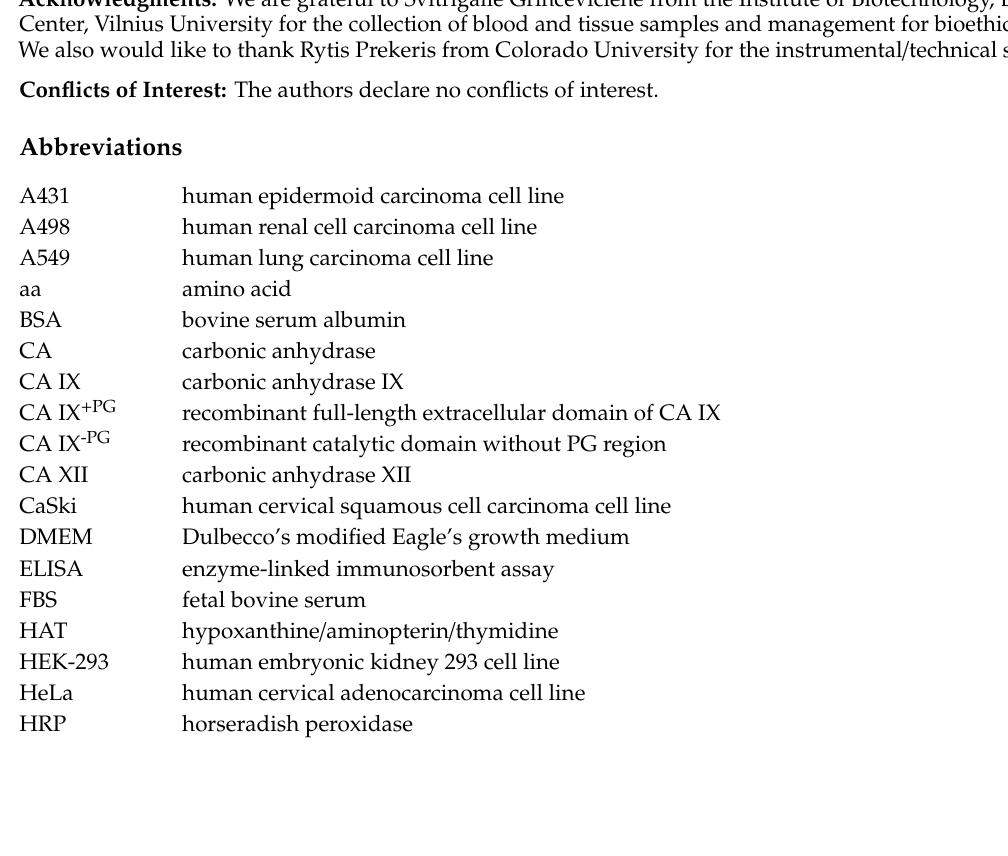
Table S1: Supplementary table S1—The cross-reactivity of the generated MAbs with other CA isoforms (CA I, II, IV, VB, VI, VII, XII, XIII, and XIV) investigated by indirect ELISA using recombinant proteins as antigens. Green color—positive reaction (optical density at 450 nm is provided). PAbs—polyclonal antibodies obtained from mouse that has been immunized with CA IX + PG and used for hybridization. GM—fresh growth medium for hybridoma cultivation was used as a negative